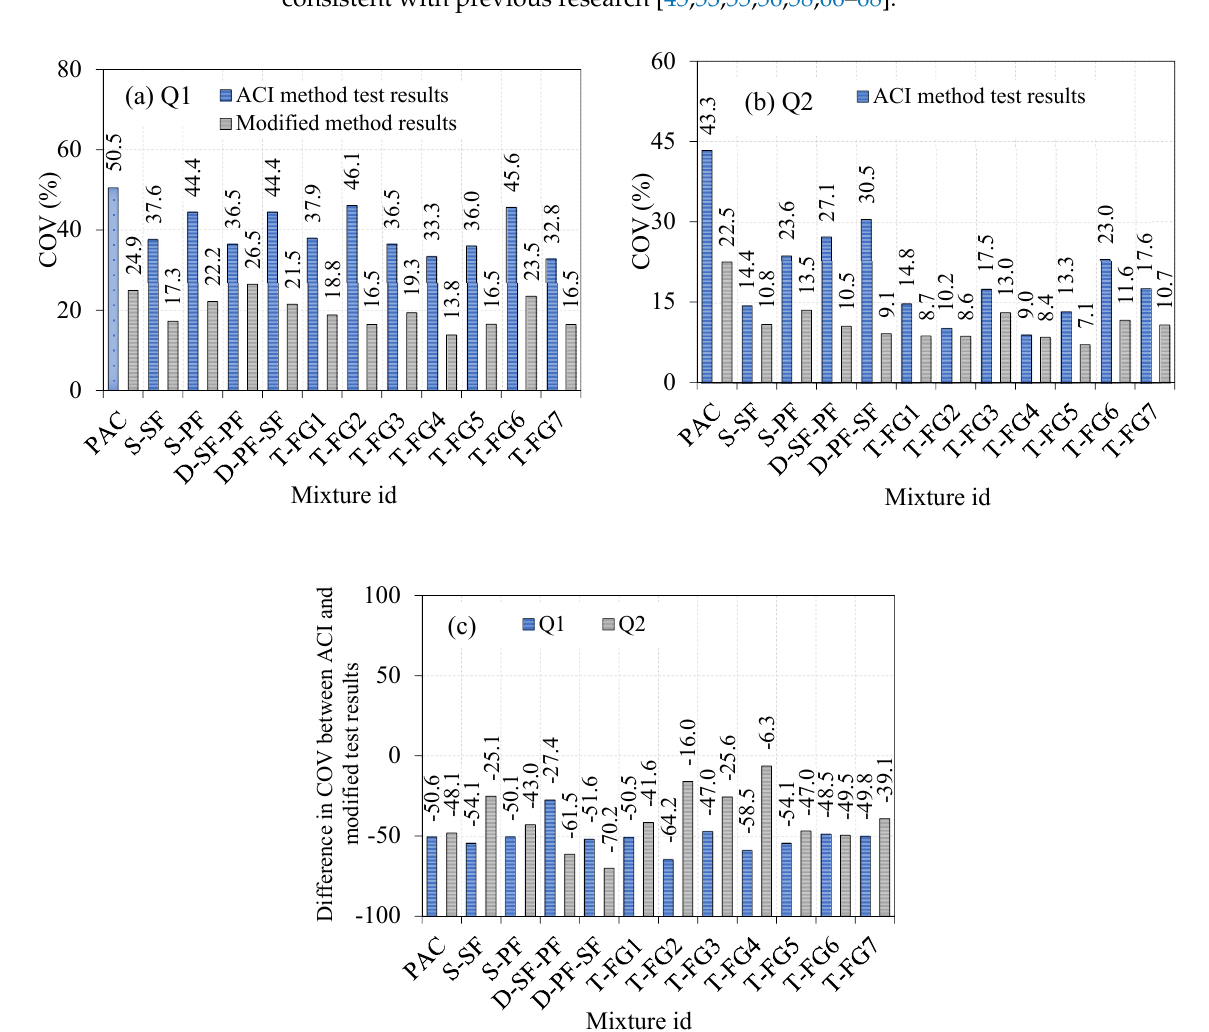
Figure 16. Comparison of COV with ACI and modified-method impact results ( a ) Q1 ( b ) Q2 ( c ) Percentage difference in Q1 and Q2.